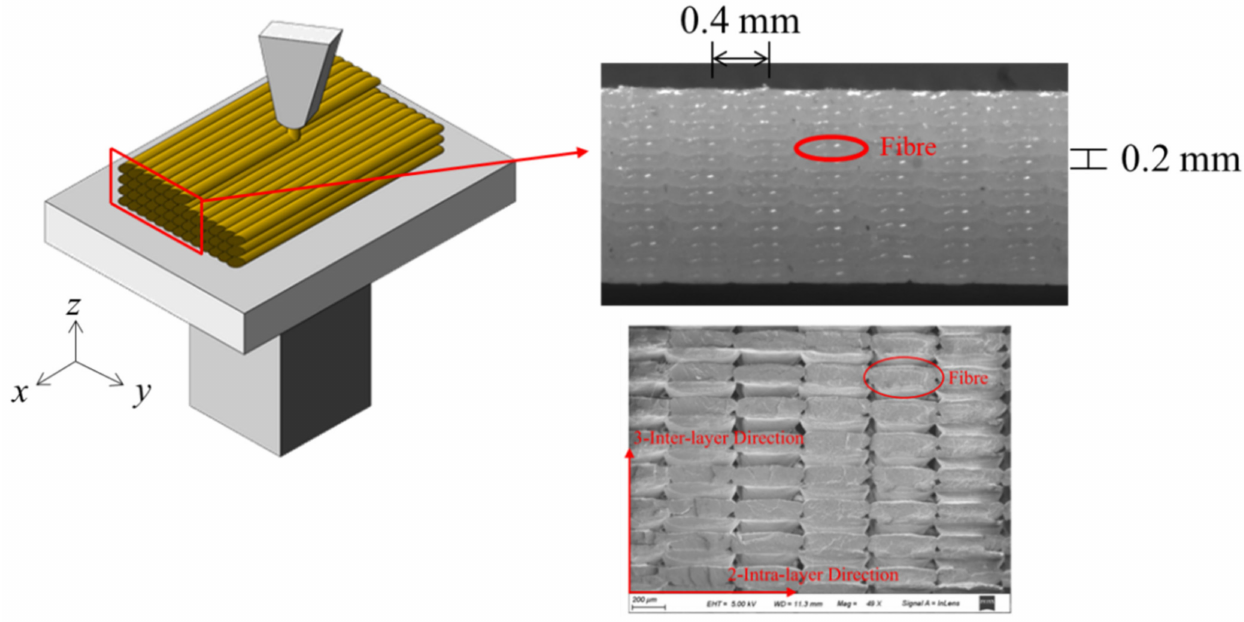
Figure 3. Printing direction and